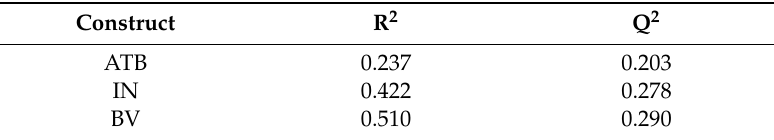
Table 2. Evaluation of the inner model ( n =